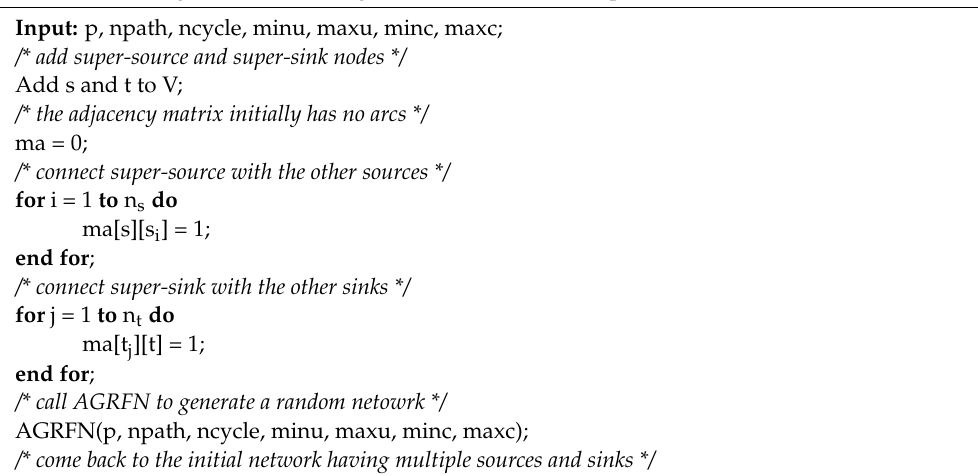
Algorithm 8. Algorithm Generating Random Network Multiple Sources and Sinks